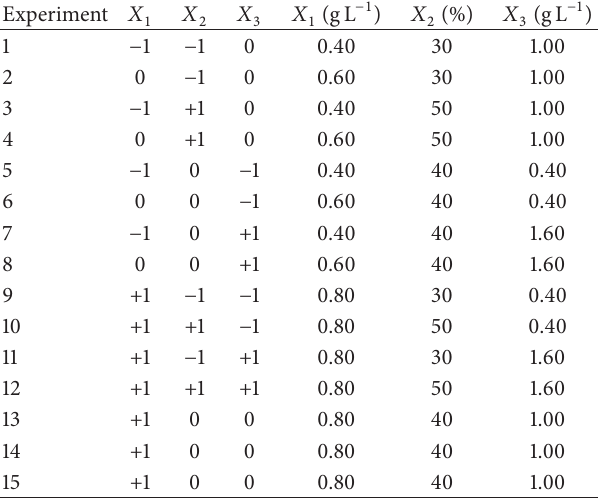
Table 1: Matrix of the Box-Behnken type factorial design with the coded variables and their respective levels of